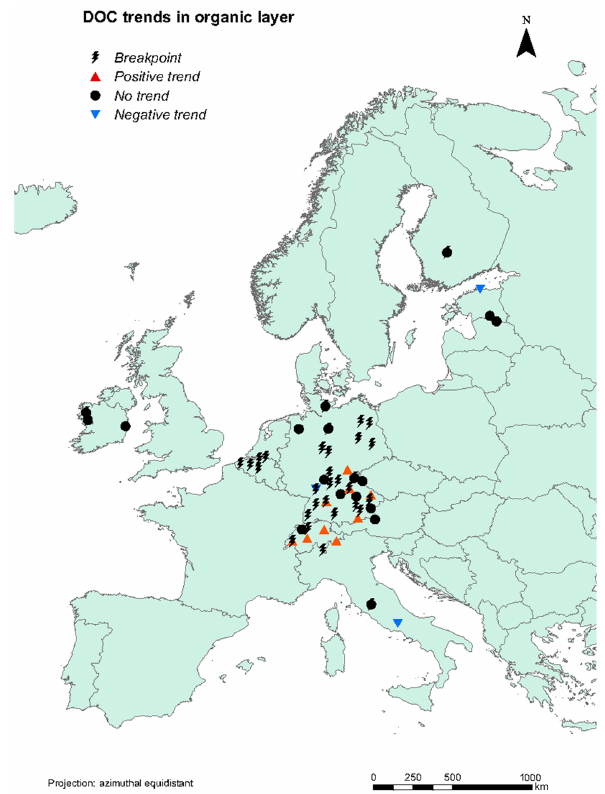
Figure 3. Directions of the temporal trends in soil solution DOC concentration in the organic layer at plot level. Trends were evalu- ated using the seasonal Mann–Kendall test. Data span from 1991 to